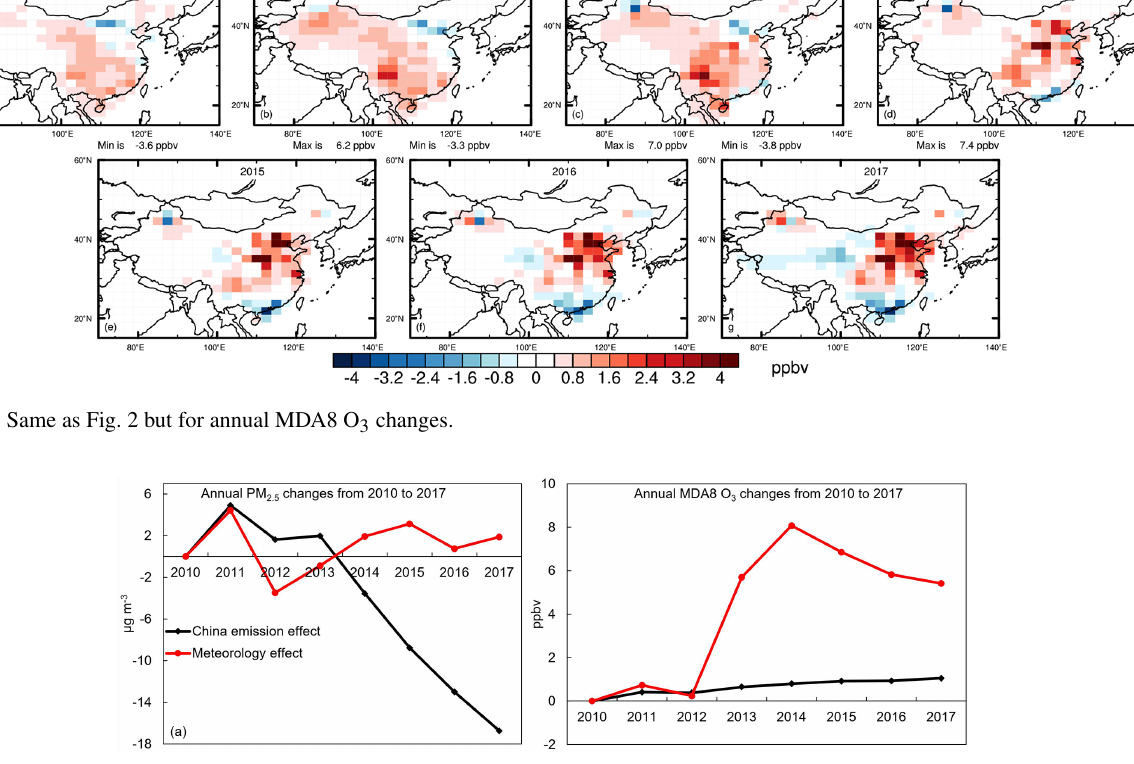
Figure 4. The annual PM 2 . 5 (a) and MDA8 O 3 (b) changes in China due to emissions and meteorological changes from 2010 to